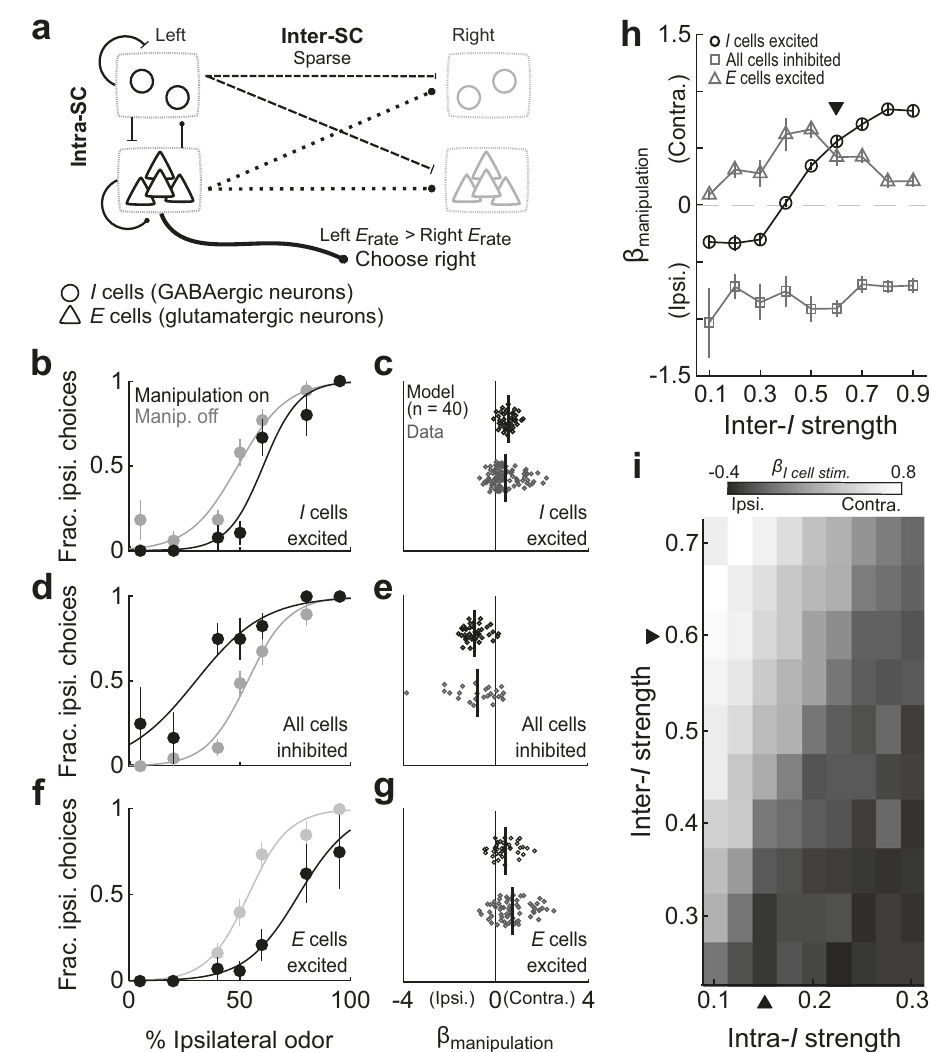
Fig. 6 The relative weight of local and intercollicular inhibition can explain the contralateral choice bias produced by photoactivation of GABAergic SC neurons. a Attractor model schematic. b Unilateral excitation of inhibitory ( I ) cells during spatial choice in the model (compare to Fig. 2a). c Effect of unilaterally exciting I cells in model sessions ( n = 40, p < 0.0001, Wilcoxon signed-rank test) and of experimental photoactivation of GABAergic neurons (data in Fig. 2b). Black line, mean effect across sessions. d Unilateral inhibition of E and I cells in the model (compare to Fig. 2c). e Effect of unilaterally inhibiting E and I cells in model sessions ( n = 40, p < 0.0001, Wilcoxon signed-rank test) and of experimental local inhibition (data in Fig. 2d). Black line, mean effect across sessions. f Unilateral excitation of E cells during spatial choice in the model (compare to Supplementary Fig. 4a). g Effect of unilaterally exciting E cells in model sessions ( n = 40, p < 0.0001, Wilcoxon signed-rank test) and of experimental photoactivation of glutamatergic neurons (data in Supplementary Fig. 4b). Black line, mean effect across sessions. h Effect of manipulations in model sessions depends on strength of intercollicular projections of I cells (inter- I ). Each symbol shows mean ± SEM. Arrowhead, strength in ( b – g ). i Effect of exciting I cells depends on relative strength of their intercollicular (inter- I ) and intracollicular (intra- I ) projections. Each element shows mean across 40 sessions. Arrowheads, strengths in ( b – g